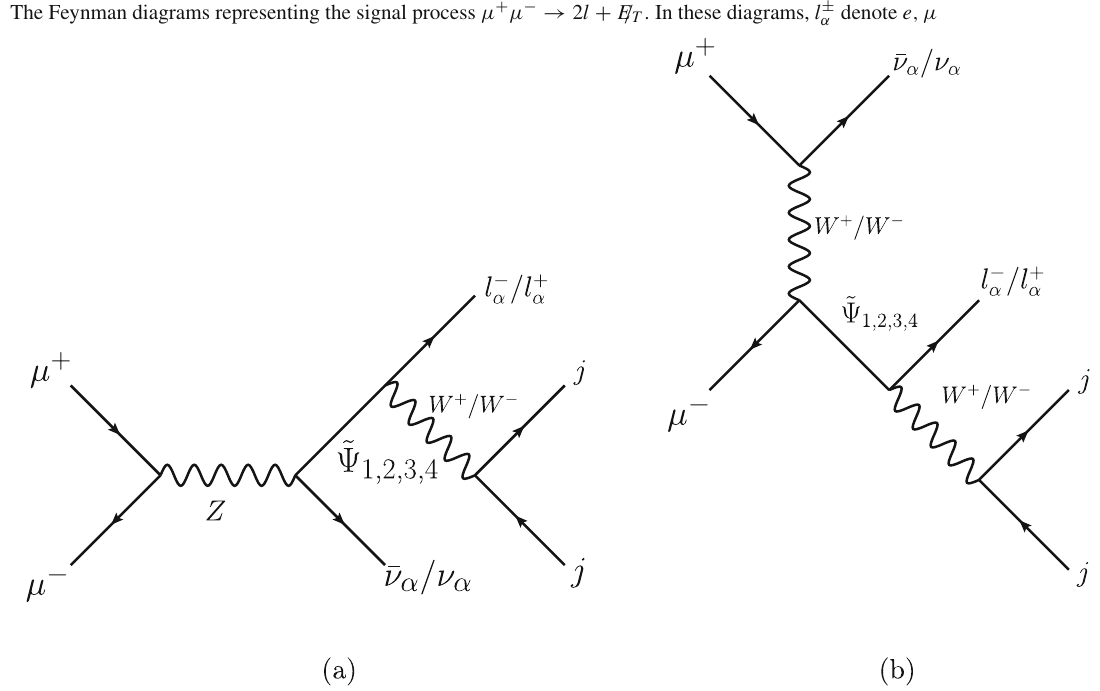
Fig. 4 The Feynman diagrams representing the signal process μ + μ − → 1 l + 2 j + E T / . In these diagrams, l ± α denote e